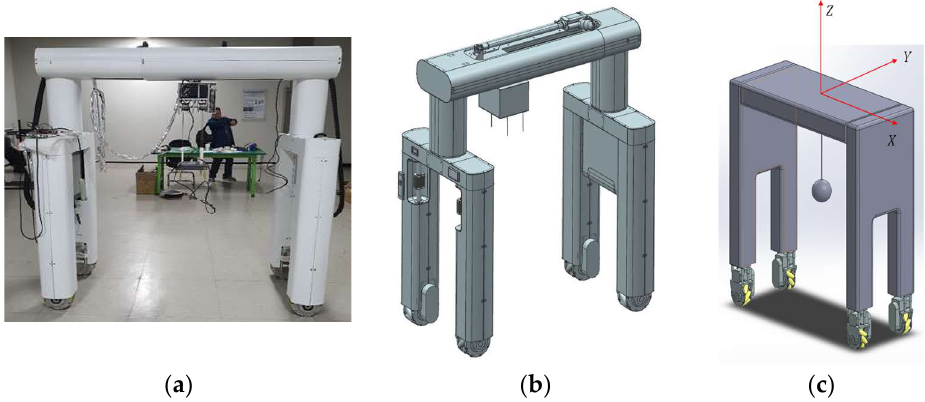
Figure 12. A patient transfer robot: ( a ) A prototype of the PTR, ( b ) 3D model of the patient transfer robot, ( c ) simplified model of patient transfer robot [30].